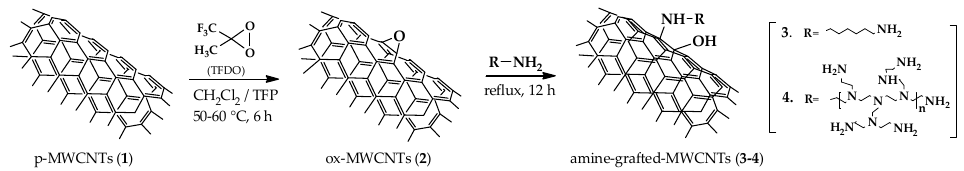
Figure 1. Synthesis of amine-grafted carbon nanotubes 3 - 4 .